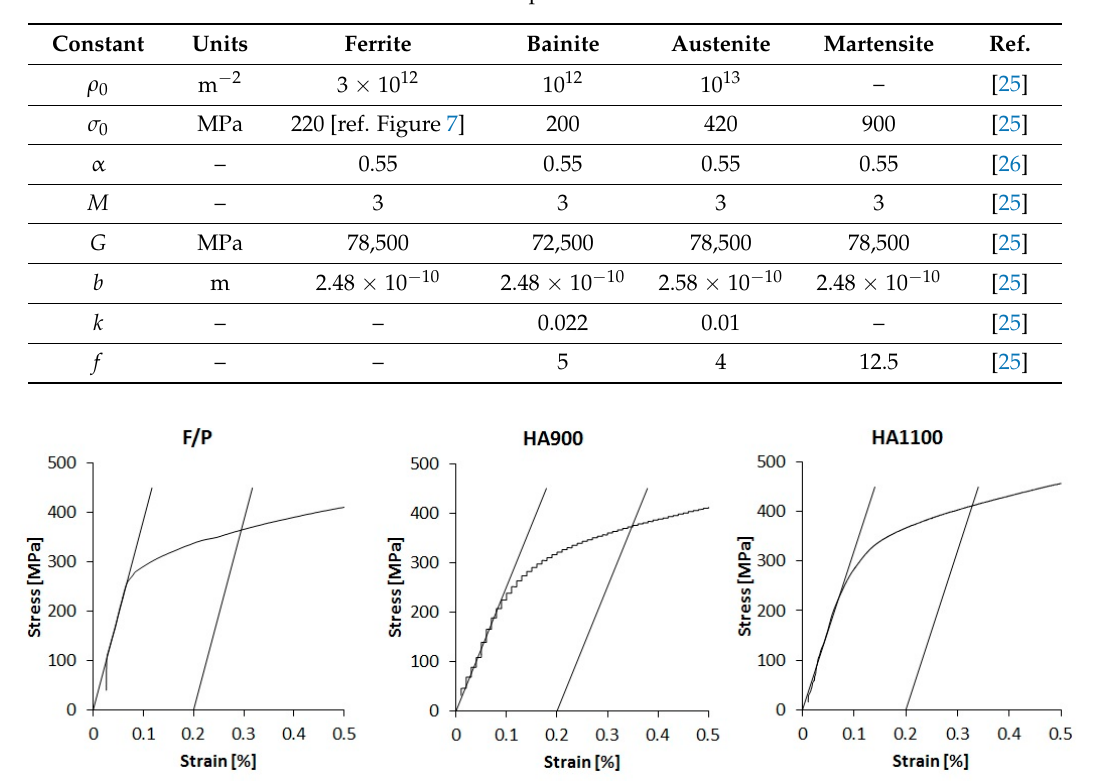
Figure 7. Stress vs. strain curves on representative samples for each steel.